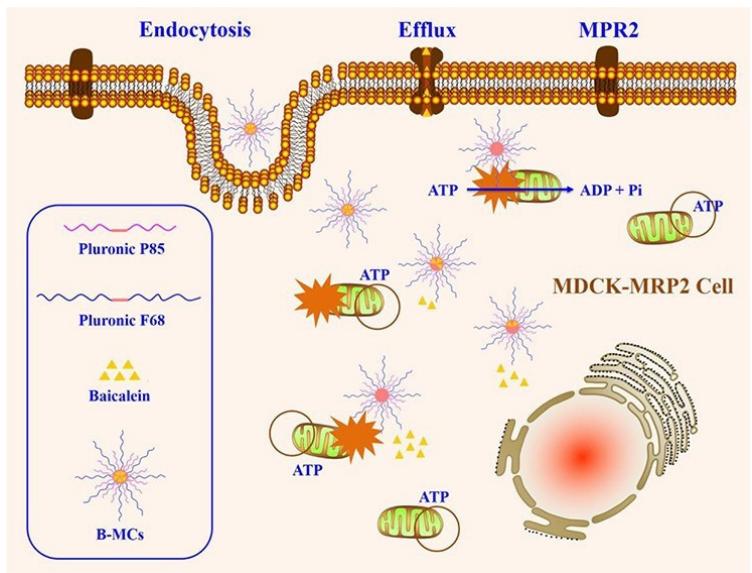
Figure 3. Schematic illustration of the mechanism on overcoming MRP2 of B-MCs. Reprinted with permission from [83]. Copyright© 2017 American Chemical Society.